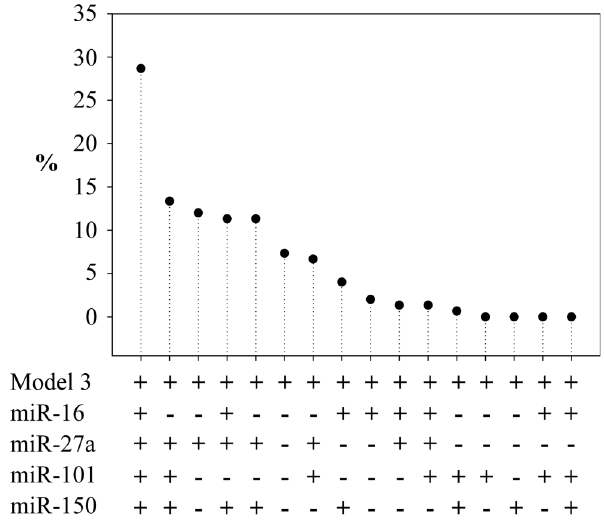
Figure 4. Bootstrap internal validation (censored regression). Represented is the percentage of times a combination of miRNAs was selected as providing the best improvement of the prediction of model 3 over 150 bootstrap